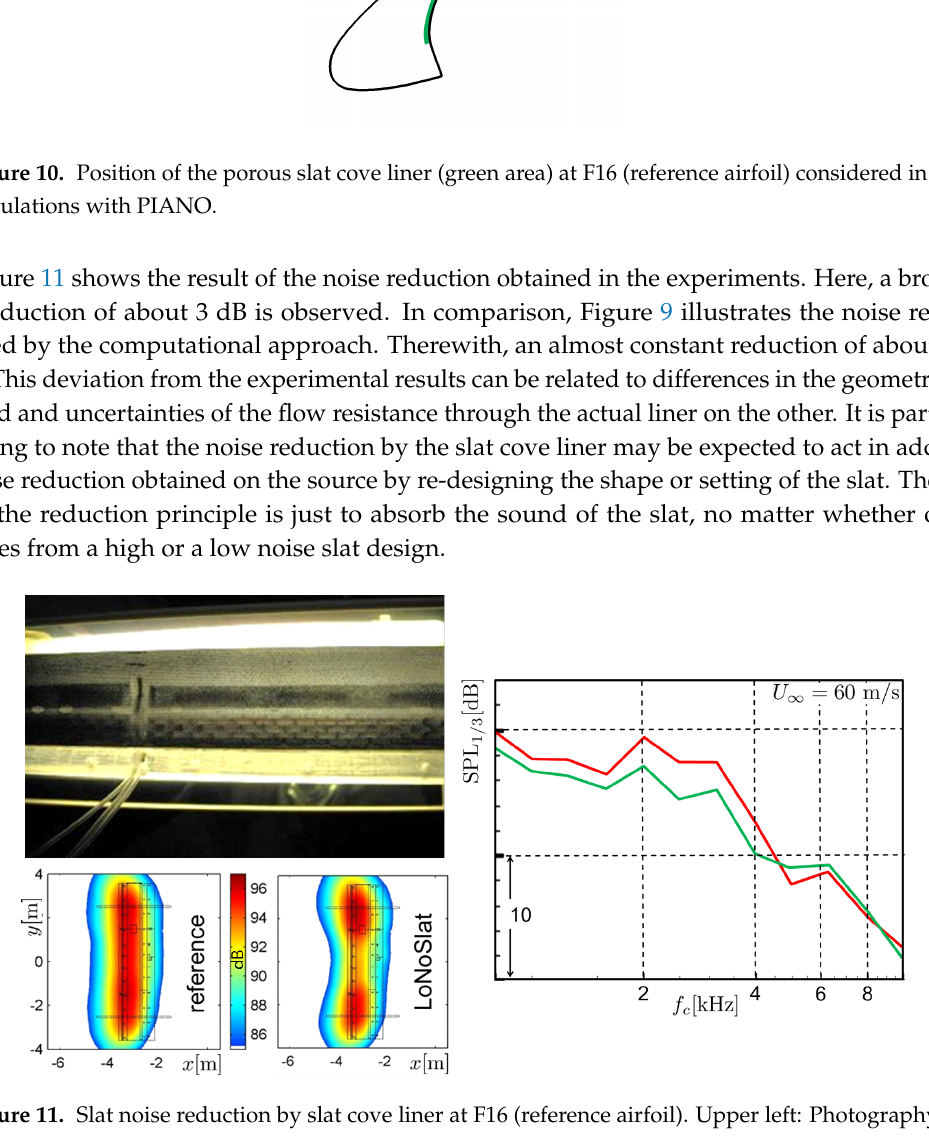
Figure 11. Slat noise reduction by slat cove liner at F16 (reference airfoil). Upper left: Photography of slat with cove liner (view upstream towards slat trailing edge), lower left: microphone array source localization with ( left ) and without ( right ) liner (only central part relevant), right: spectra taken from array data of the central part of airfoil, geometrical angle of attack of airfoil 16